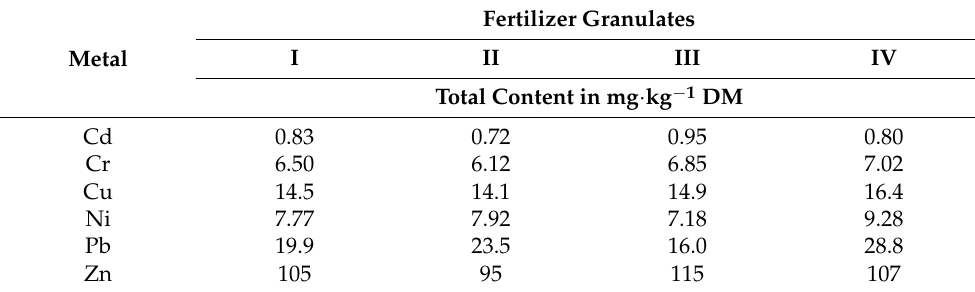
Table 2. The content of heavy metals in the produced sludge-ash granulates.